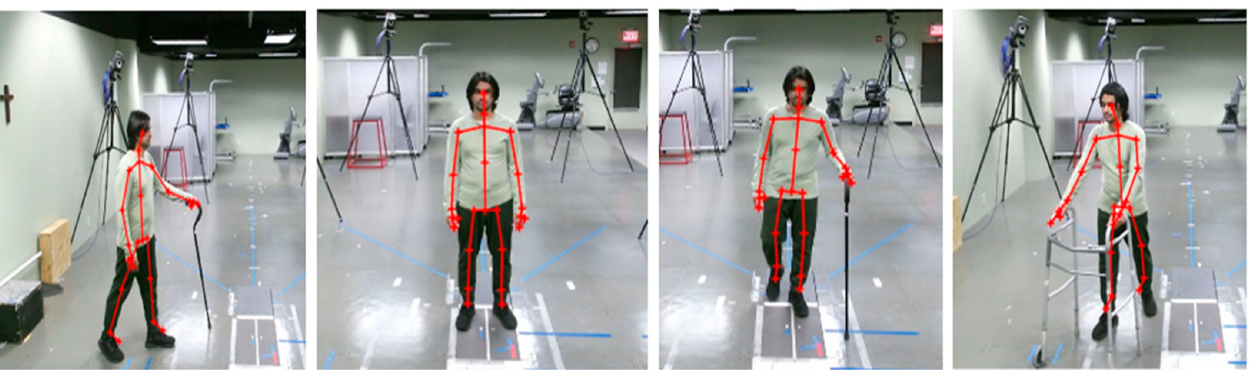
Figure 11. Joint estimation during the data collection process for different activities.